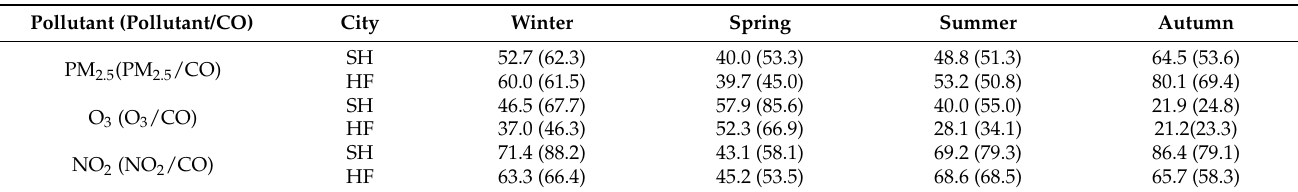
Table 4. Seasonal mean concentrations of PM 2.5 , O 3 , and NO 2 under calm conditions in Shanghai (SH) and Hefei (HF) (unit: µ g/m 3 ). The values in brackets are the ratios of PM 2.5 , O 3 , and NO 2 to CO under calm conditions.